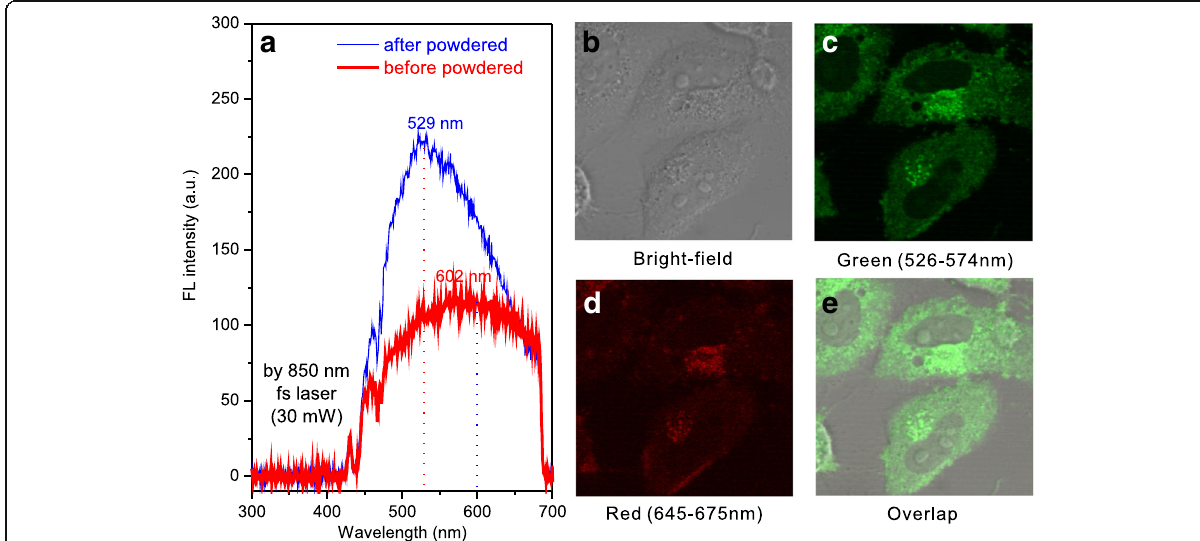
Fig. 4 Two-photon photoluminescence spectra of SA-CPDs ( a ) and confocal fluorescence microscopy images of HeLa cells treated with SA-CPDs excited by 850 nm, 30 mW femtosecond pulse laser ( b – e